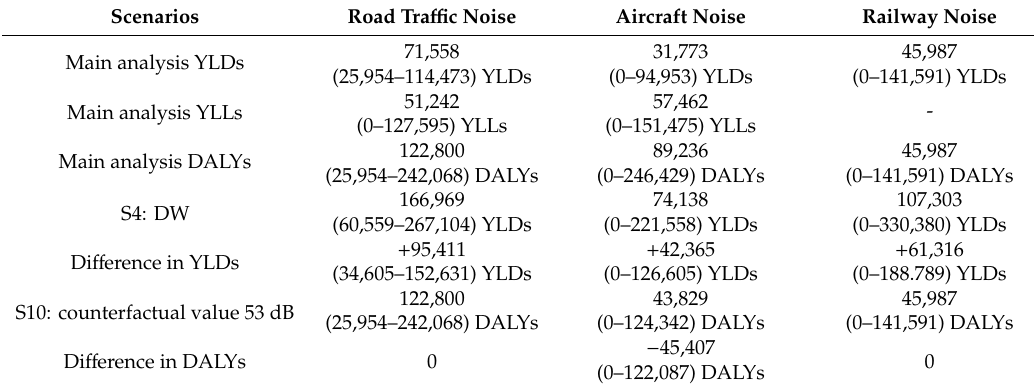
Table 10. Sensitivity analysis of the burden of disease due to ischemic heart disease attributable to tra ffi c noise in Germany, 2016 (95% CI in